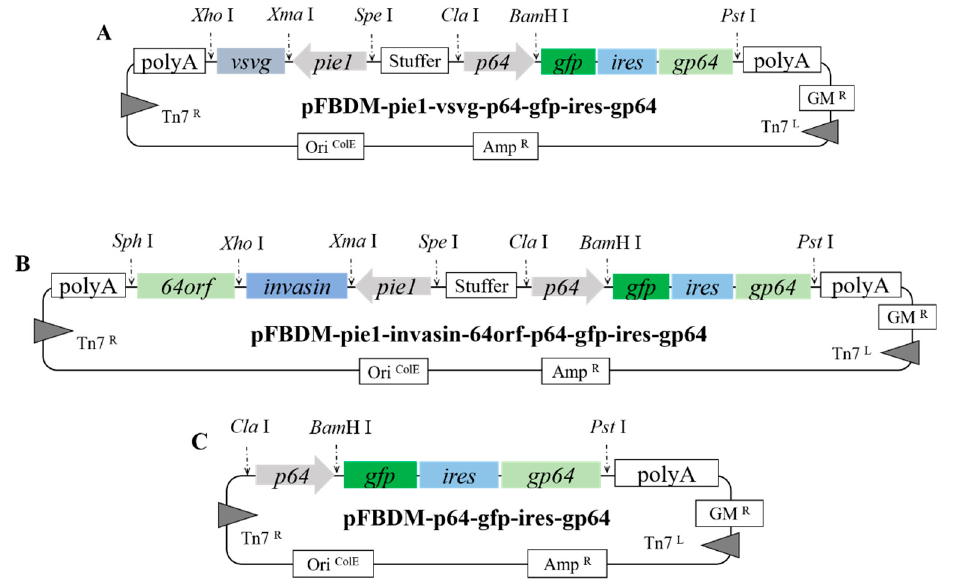
Figure 2. Construction of recombinant plasmids pFBDM carrying vsvg and invasin . The gene expression cassettes pie1-vsvg-polyA and pie1-invasin-64orf-polyA realize the modification of the recombinant baculovirus envelope through protein fusion, respectively, to improve the efficiency of recombinant baculovirus transduction into mammalian cells. ( A ) The map of the plasmid pFBDM- pie1-vsvg-p64-gfp-ires-gp64. ( B ) The map of the plasmid pFBDM-pie1-invasin-64orf-p64-gfp-ires-